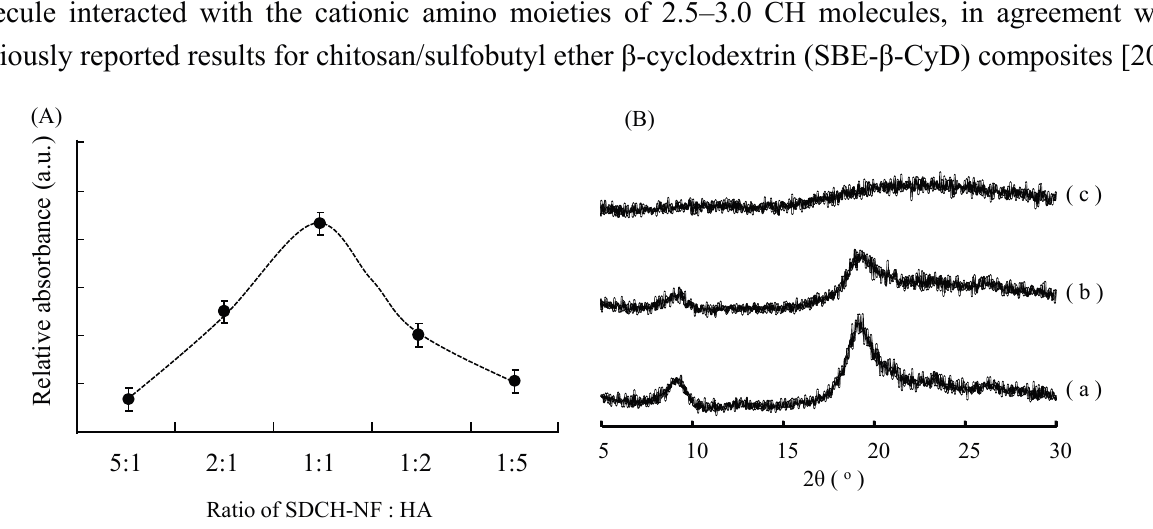
Figure 2. Effect of the ratio of SDCH-NF and HA on the transmittance of the solution ( A ) and powder XRD patterns of SDCH-NF alone (a), SDCH-NF/HA complex (1:1) (b), and HA alone (c) ( B